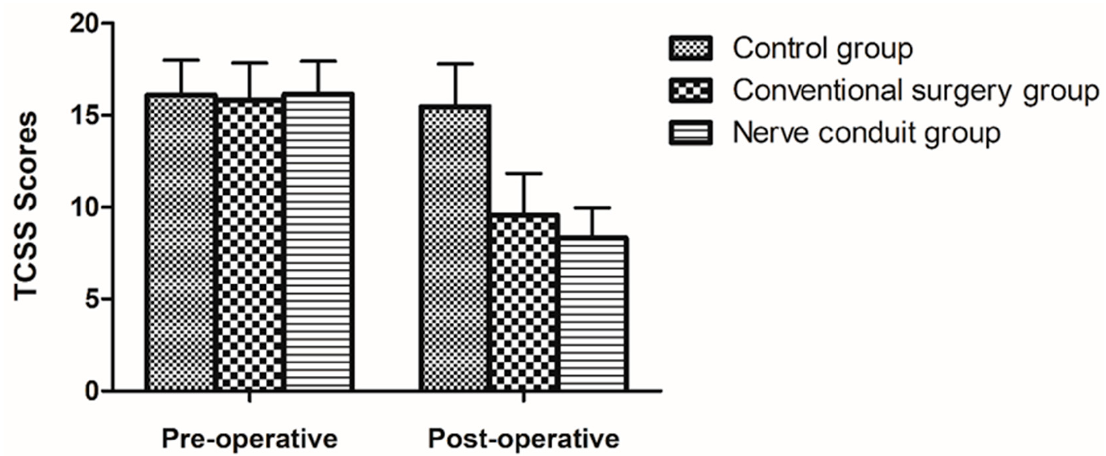
Figure 2. The figure displays the records of the TCSS scores in all groups (mean ± Figure 2. The fi gure displays the records of the TCSS scores in all groups (mean ± SD).